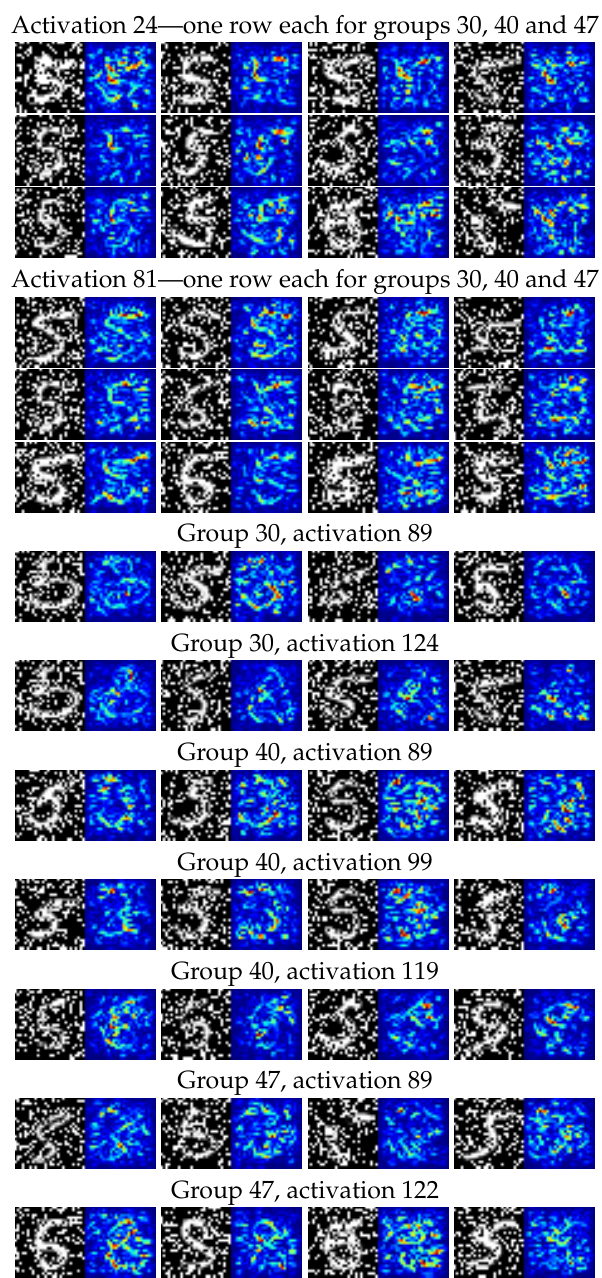
Figure 8. Examples of noisy images and saliency maps for activations in the penultimate dense layer for the three main failure modes identified for noisy 5s. The two leftmost images were chosen as the most clear saliency maps with respect to digits. The two rightmost were selected based on unclear/noisy saliency maps. All saliency maps are from images classified as members of the respective failure mode group. All saliency maps can be found in our Supplementary Material